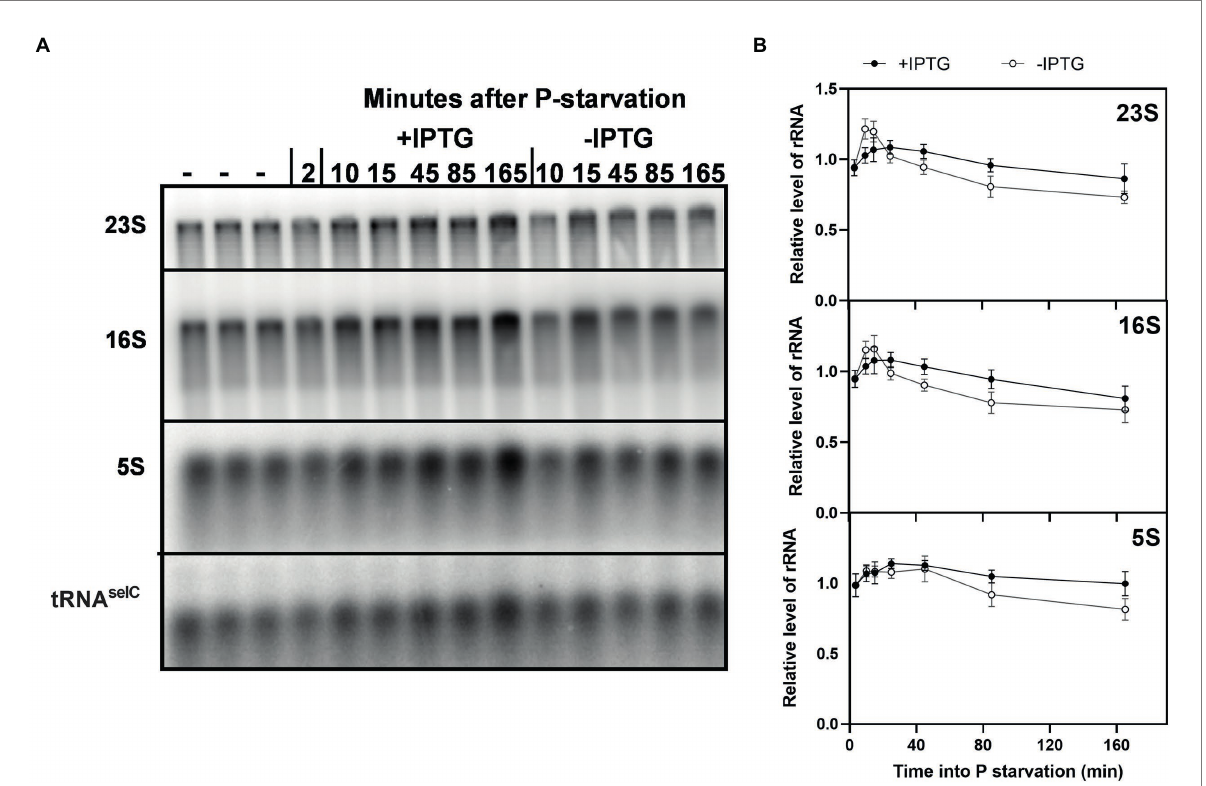
FIGURE 5 Induction of a long-lived hybrid mRNA resulted in higher levels of full-length rRNA during P starvation. (A) A 1.5% agarose denaturing gel was used for separation of RNA samples from E. coli strain MAS1143 ( lacI q1 lacZ ::Tn5)/pIV18 before (–) and after P starvation. After starvation, the culture was split, and IPTG was added to one of the cultures at t = 5 min. Five per cent spike-in cells overexpressing the rare tRNA selC were added to each sample for normalization (see Methods). The RNA was transferred from the agarose gel to a Hybond N+ membrane, and probed for 23S, 16S, 5S, and tRNA selC . (B) Quantification of full length 5S, 16S, and 23S normalized to tRNA selC are shown relative to the average of the three RNA samples harvested during balanced growth prior to starvation. The shown values correspond to the mean of five independent biological replicates, and the error bars indicate the